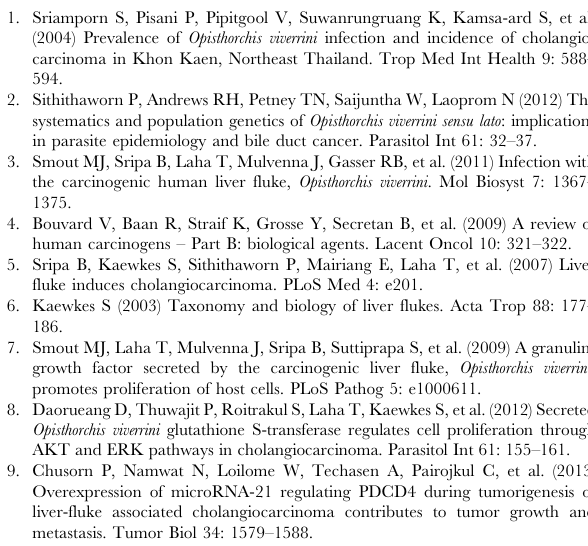
Table S2 Differentially expressed genes (DEGs) inferred from the transcriptomes of uninfected and Opisthorchis viverrini -infected Bithynia siamensis goniomphalos snails (UB and IB, respectively).